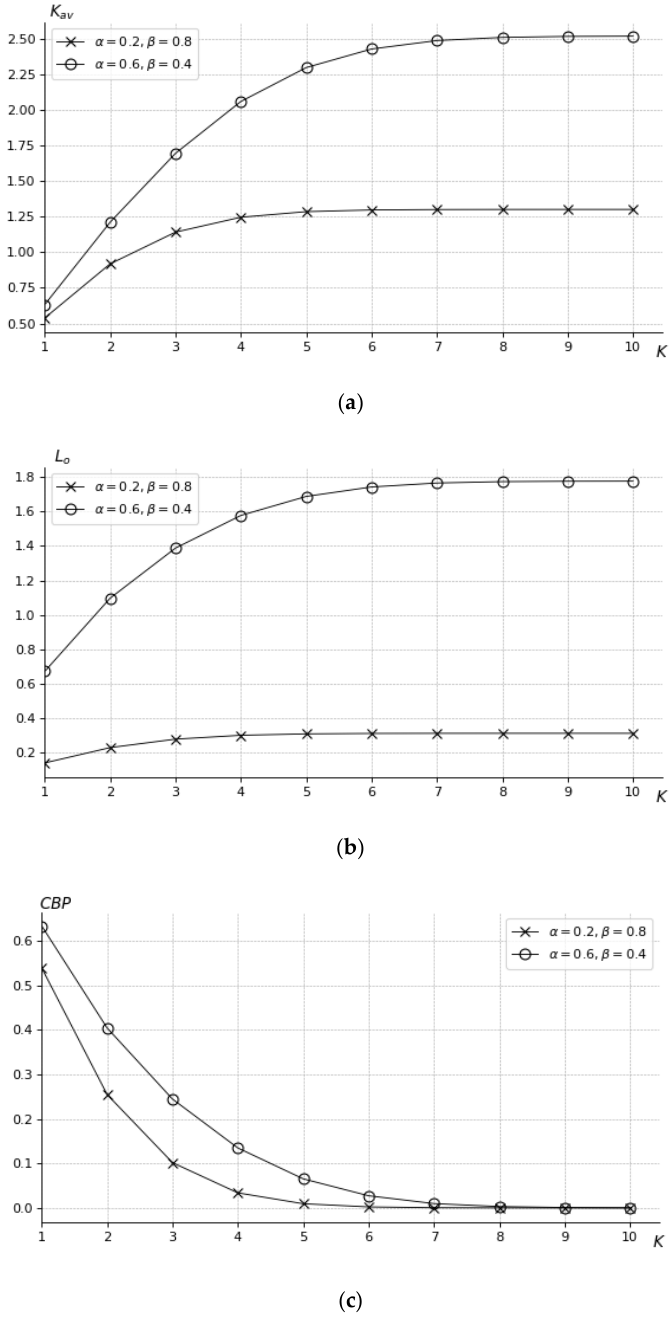
Figure 4. Dependency K av ( a ), L o ( b ) and CBP ( c ) on K for state-independent feedback and retrial probabilities.